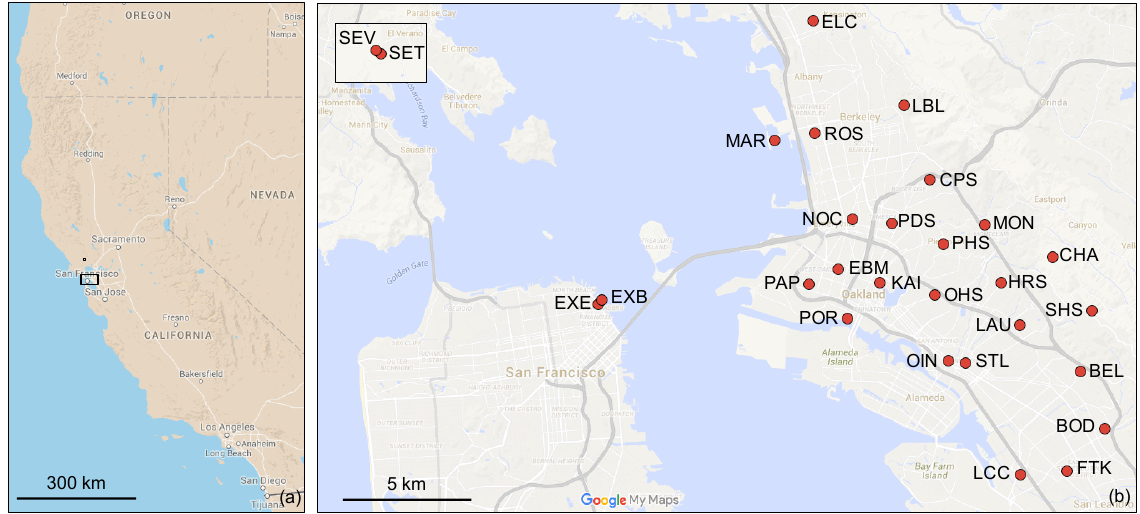
Figure 1. Map of the BEACO 2 N domain (a) in the context of the western United States and (b) showing individual node locations. Inset in panel (b) shows the pair of nodes stationed in Sonoma County.